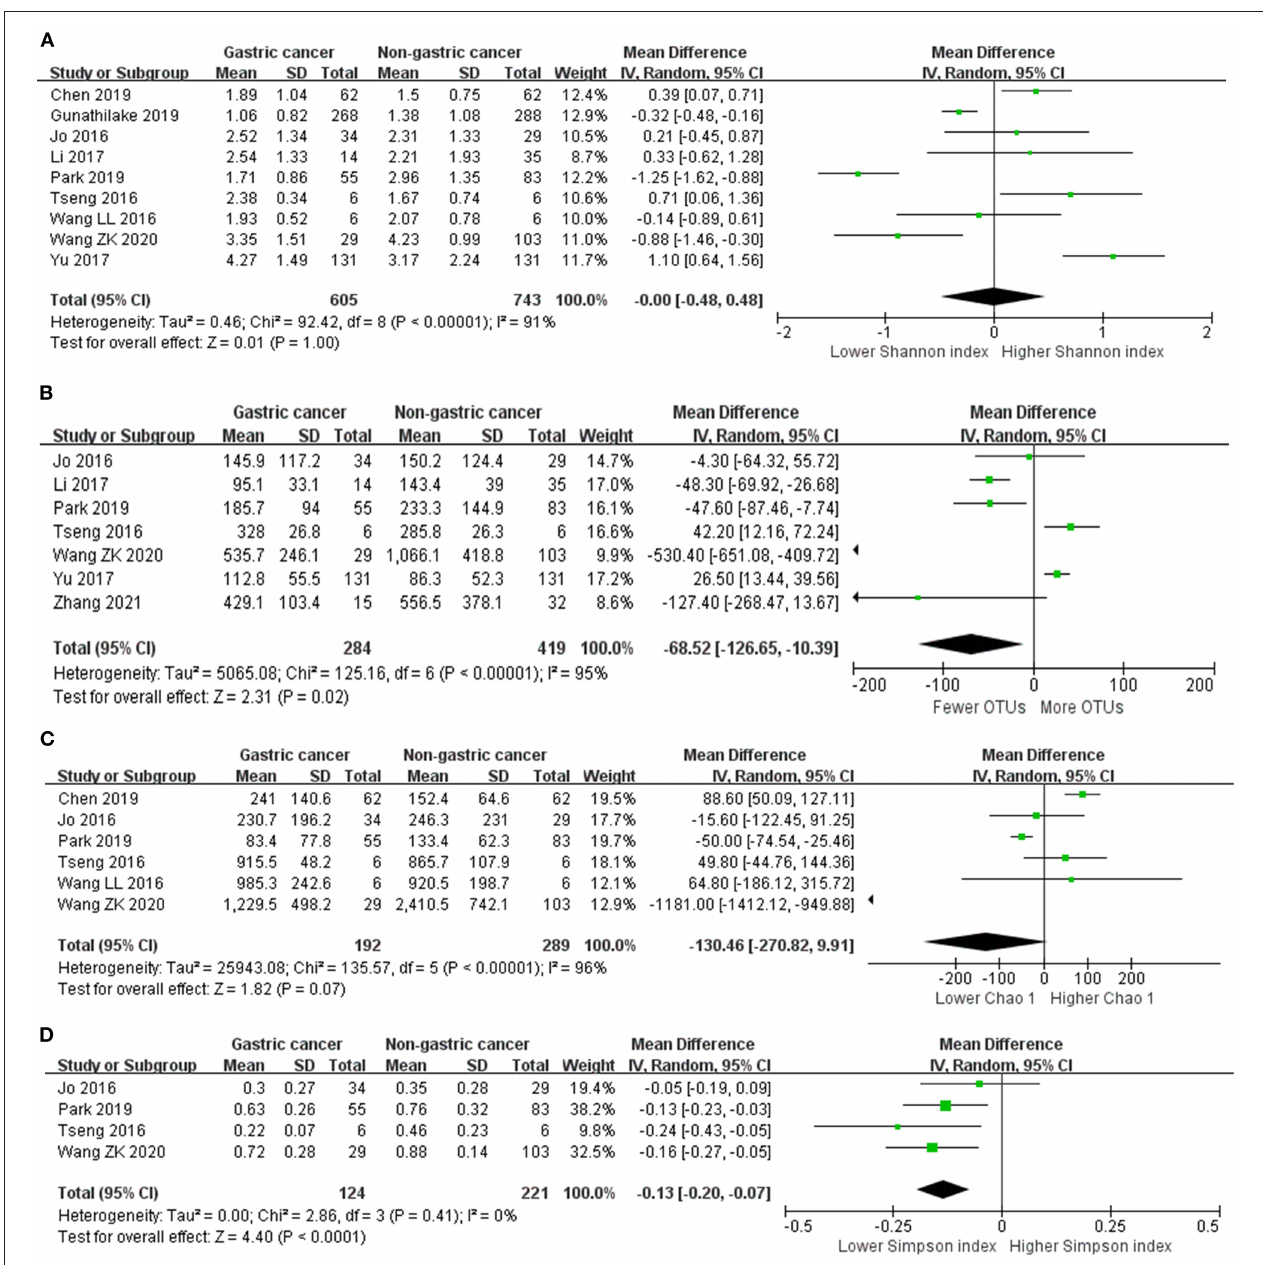
FIGURE 2 | Forest plot for changes in alpha diversity indexes including Shannon index (A) , OTUs (B) , Chao 1 (C) , and Simpson index (D) between gastric cancer and non-gastric cancer groups.